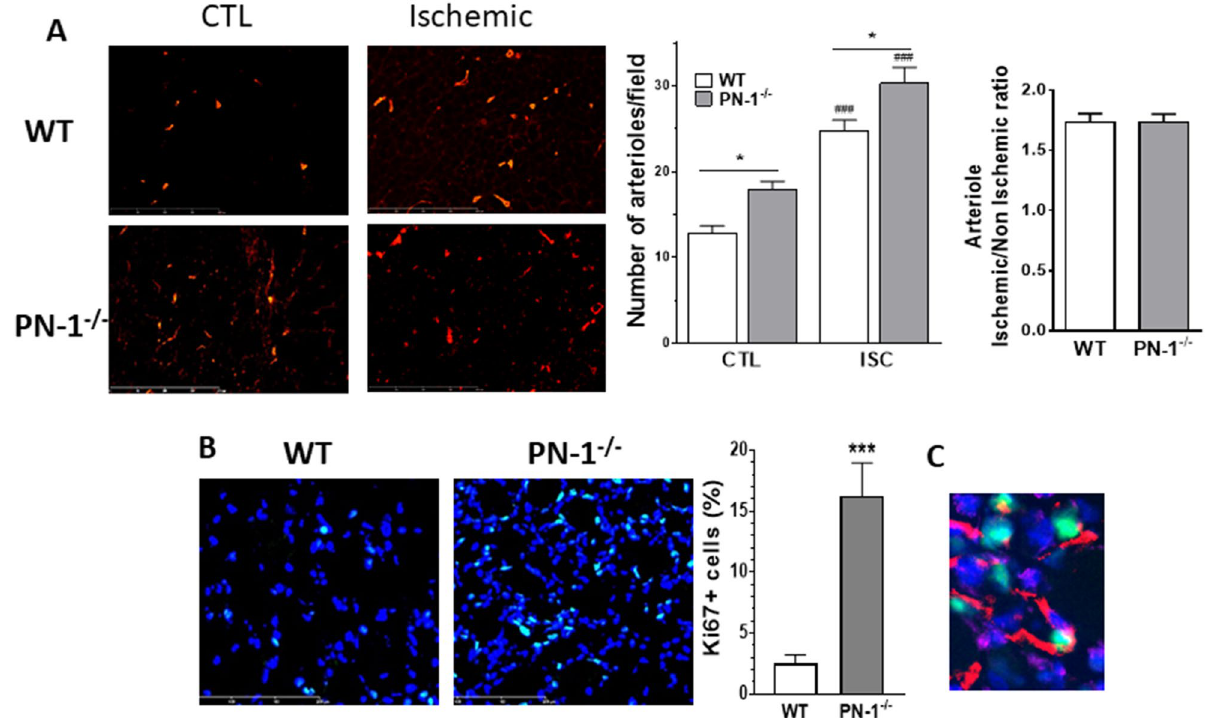
Figure 4. PN-1 deficiency does not modify arteriogenesis but results in higher arterial count and greater proliferation. ( A ) Representative images of α smooth muscle actin labelling of control (CTL) and ischemic (ISC) muscles sections. Arterioles were manually counted and statistical analysis was performed with Anova test (n > 10), ( B ) Representative images of Ki67 labelling (green, DAPI in blue). No positive nuclei were observed in control muscles. Quantification was performed by counting Ki67-postive nuclei and expressed as the percentage of total nuclei. ( C ) Representative image of co-labelling of Ki67 (green) and VE Cadherin (red) on ischemic muscle section. Blue: DAPI. Statistical analysis performed with t test (n = 9): * p < 0.05; *** or ### p < 0.001; *: KO versus WT and #: ischemic versus